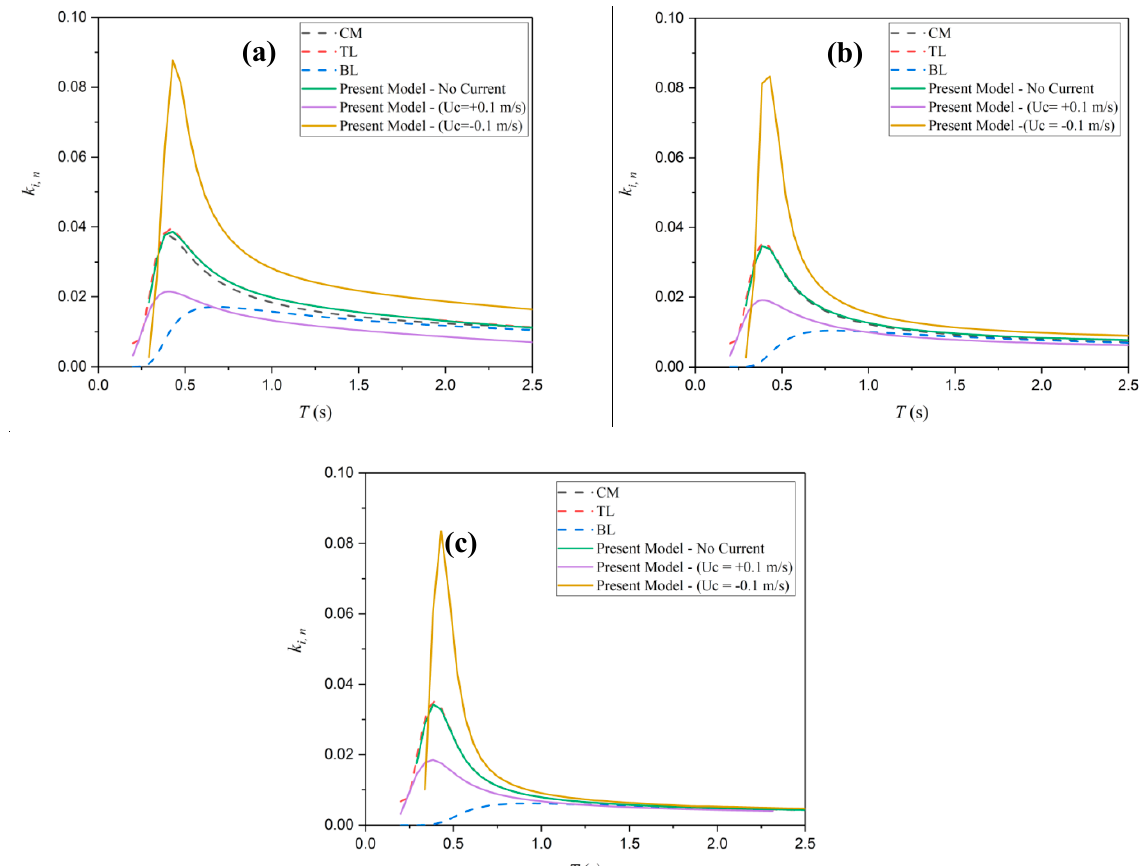
= 5; ( b ) d = 8; ( c ) d = n n